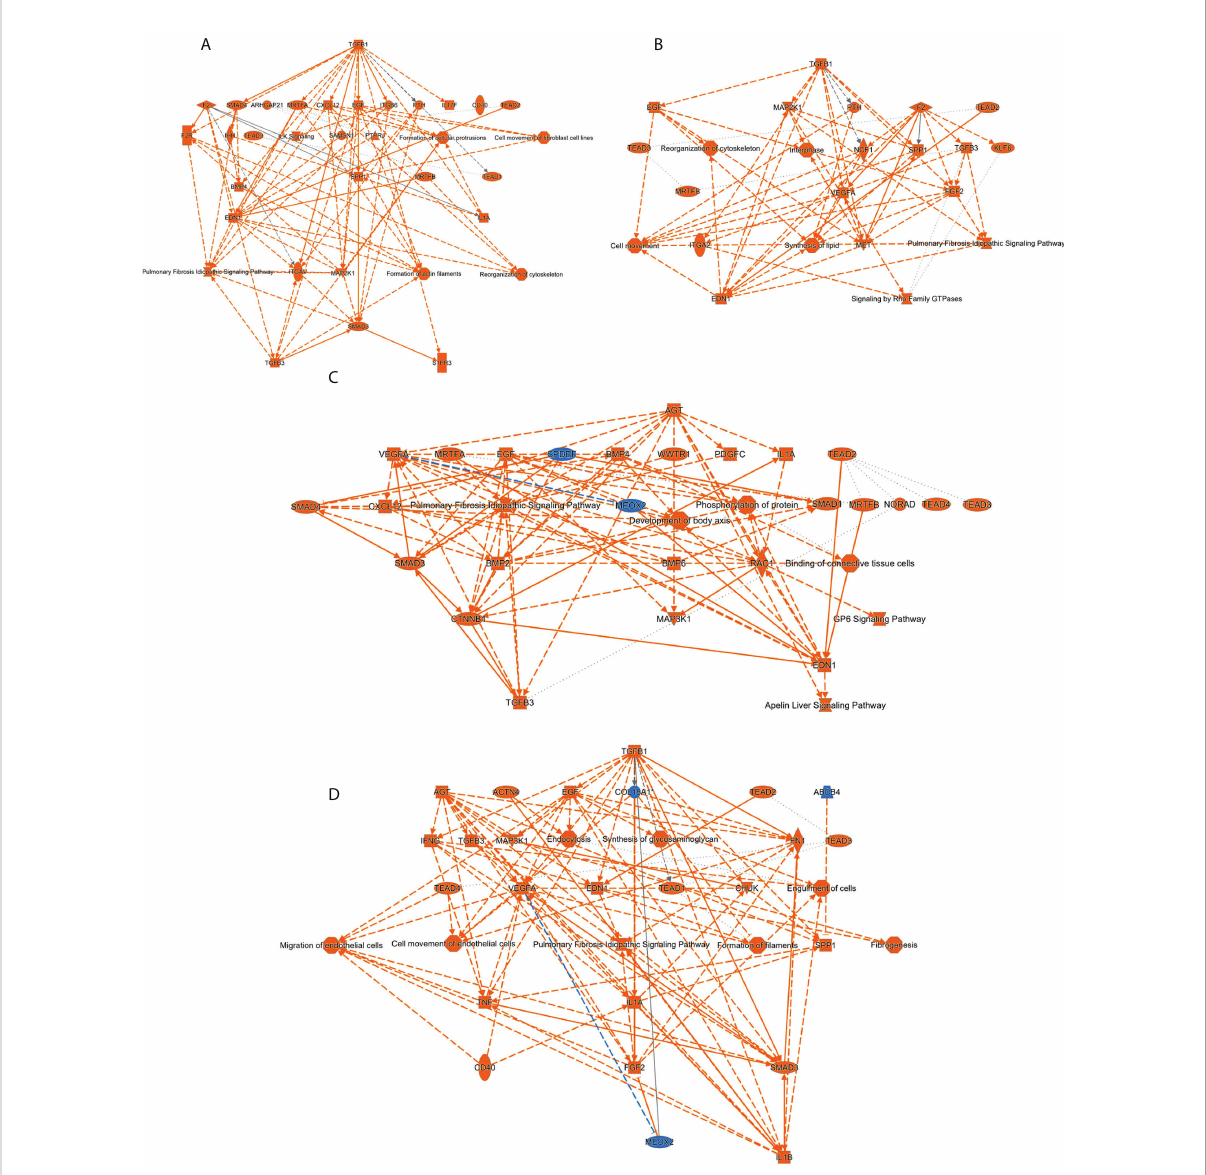
FIGURE 9 Machine learning-based analysis proposes a potential activation of TGFbeta/SMAD axis commonly induced by all SARS-CoV-2 structural proteins. The functional networks use a precomputed table containing inferred relationships between molecules, functions, diseases, and pathways obtained and scored by a machine learning algorithm operating entirely on prior knowledge. The heuristic graph algorithm present in IPA software was optimized to create a manageable network that brings together the most signi fi cantly activated (in orange; positive Z-score) or inhibited (in blue; negative z-score) upstream regulators, diseases, functions, and pathways from the differential proteotranscriptomic alterations induced by each SARS-CoV-2 structural proteins: (A) SARS-CoV-2 E protein; (B) SARS-CoV-2 M protein; (C) SARS-CoV-2 N protein; (D) SARS- CoV-2 S